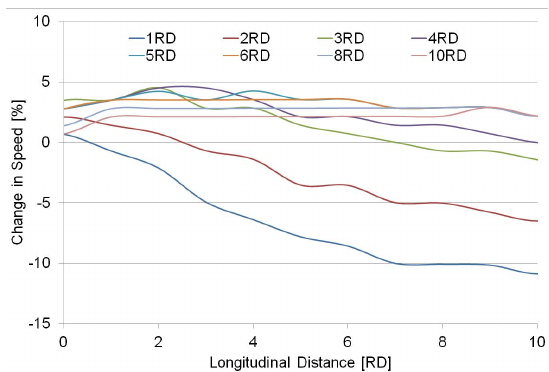
Figure 12. Change (%) in current speed along the longitudinal axis of Figure 8b.